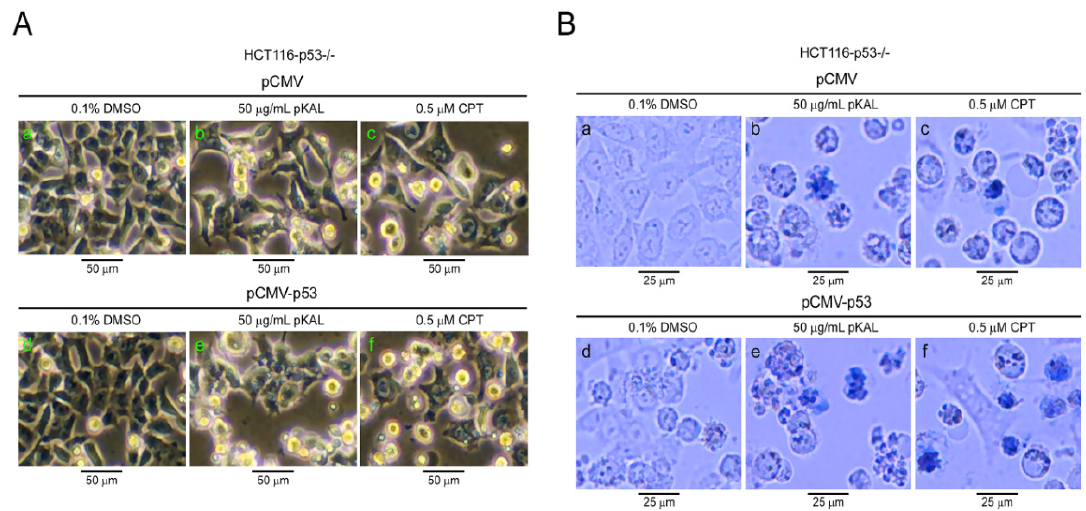
Figure 6. Effect of ectopic p53 on pKAL-induced morphological change and cell death in p53-null HCT116 cells. HCT116-p53 − / − cells were transfected with 1 µg of pCMV or pCMV-p53 plasmid DNA and then treated with 0.1% DMSO, 50 µg/mL pKAL or 0.5 µ M CPT for 48 h. ( A ) Phase-contrast light